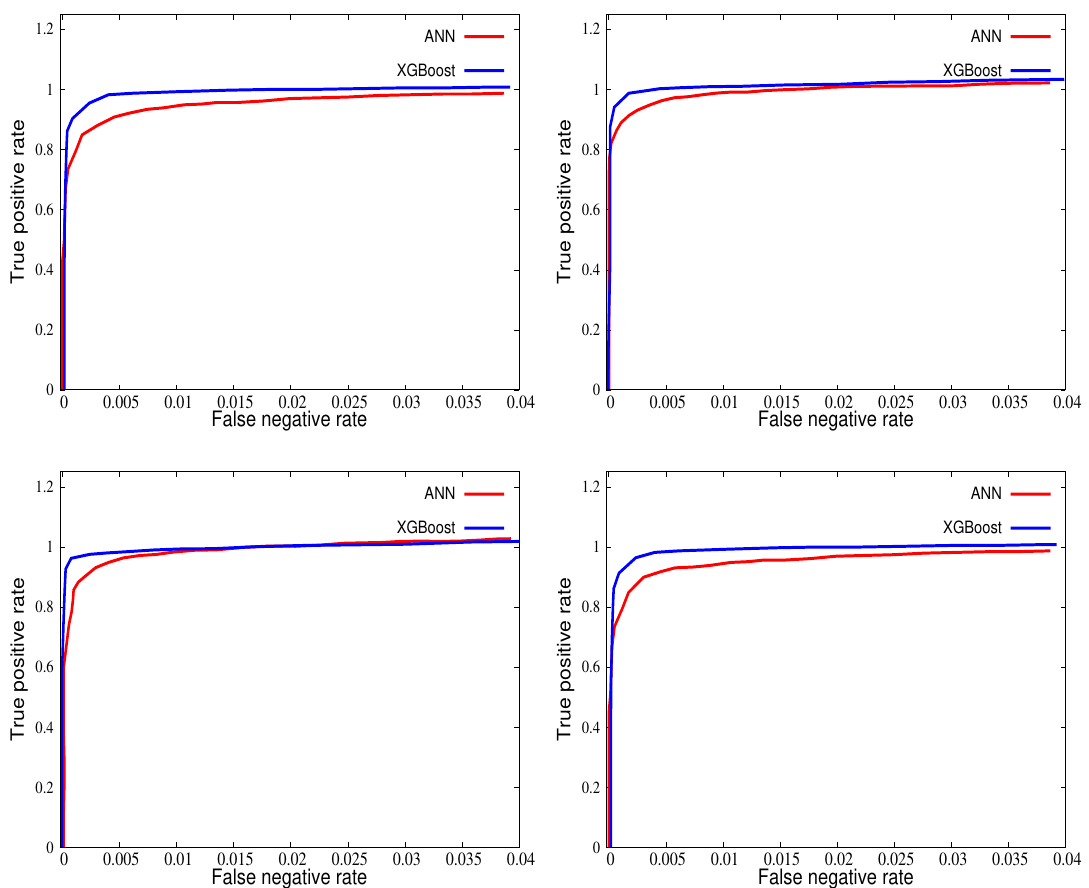
Figure 19 . ROC curves of BP1 (top left), BP2 (top right) and BP3 (bottom left) and BP4 (bottom right) in case I with ANN and XGBoost.